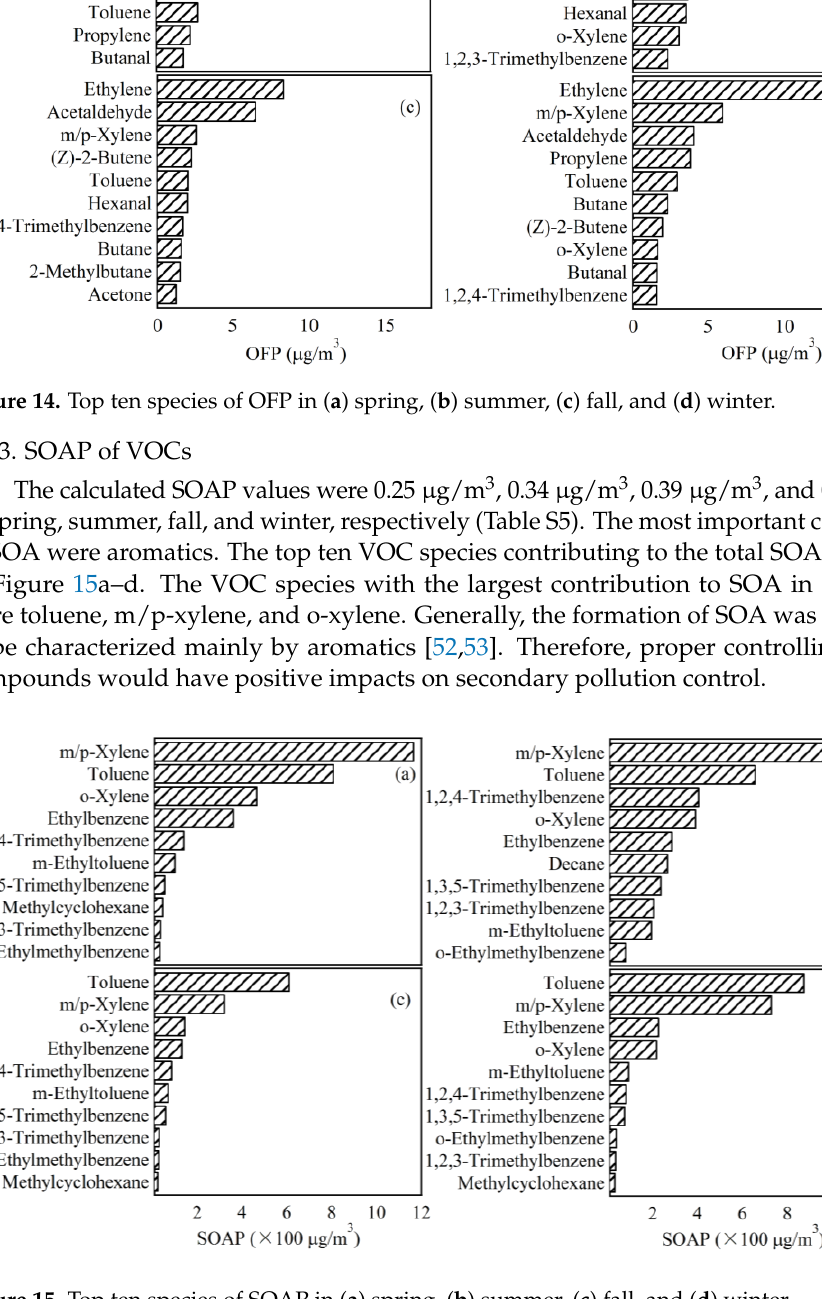
Figure 15. Top ten species of SOAP in ( a ) spring, ( b ) summer, ( c ) fall, and ( d ) winter.